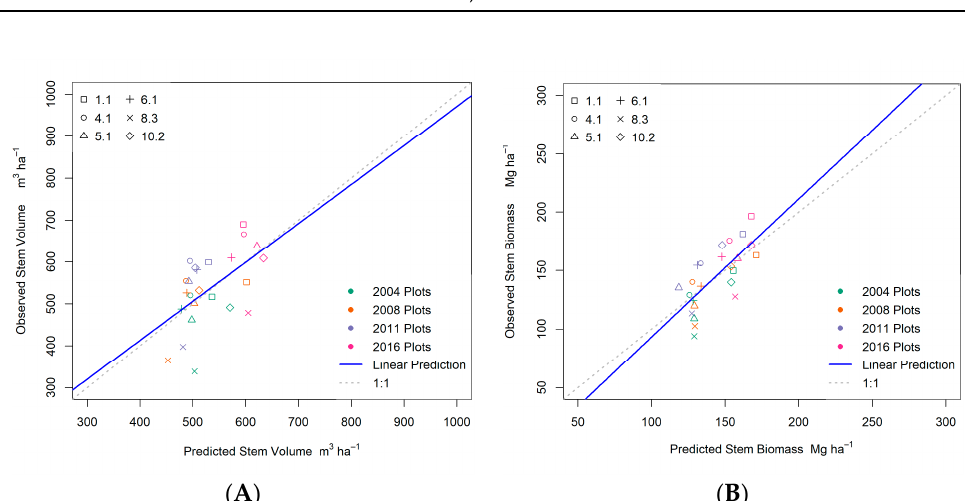
Figure 4. Observed plot level vs. RF predicted volume ( A ) and biomass ( B ) values in 2004 (green), 2008 (orange), 2011 (purple), and 2016 (pink). Across all analysis units (AUs), the modelled 2004 volumes in control blocks were higher on average (582.2 m 3 ha − 1 , SE 2.1) than in fertilized blocks (581.6 m 3 ha − 1 , SE 3.3). Cumulative increments from 2004 averaged across all AUs are shown in Figure 5A, and individual AU results are shown in Figure S1. Similar to the sample plots, across all AUs, there were no significant differences in volume increments in any year ( p -values > 0.1, Table S6). Relative to their 2004 volumes, control blocks saw an average increase of 0.5, 0.9, and 6.7 percent by 2008, 2011, and 2016, respectively. During the same time periods, fertilized blocks saw average increases of 0.7, 1.7, and 8.3 percent over their 2004 values. For AU 445, the 2005–2016 increment in fertilized blocks (44.1 m 3 ha − 1 , SE 1.1) was significantly that AU was low (3) (Figure S1E,F, Table S7). Periodic annual increments averaged across all AUs were also not significantly different between treatment blocks during any period ( p -values > 0.2, Table S8). However, for the AU that contained the sample plots (AU 146) for the period between 2009 and 2011, the fertilized blocks (2.6 m 3 ha − 1 yr − 1 ) increased at a significantly greater ( p = 0.03) rate than in the control blocks ( − 0.7 m 3 ha 1 yr − 1 ) (Table